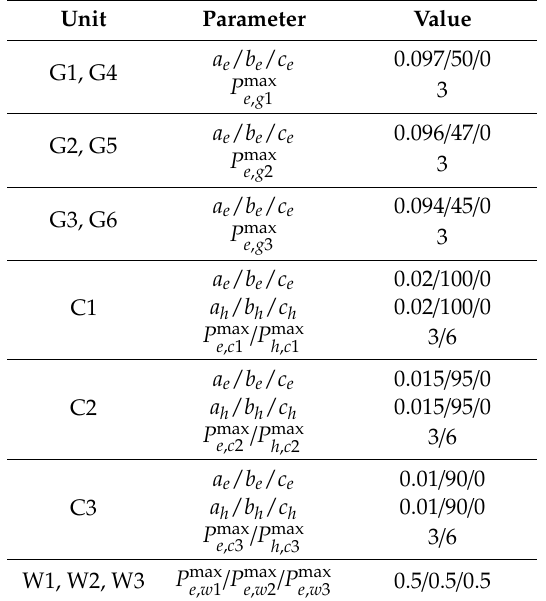
Table 2. Parameters of the generators and initial value